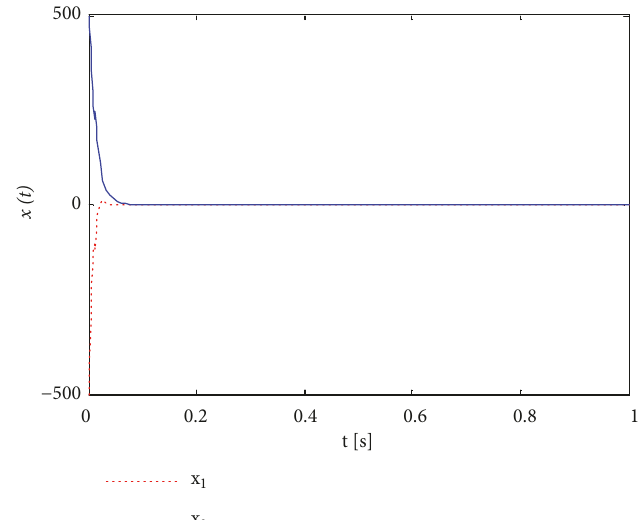
Figure 5: The state response curve of the closed-loop system under the control of the memory state feedback controller when the initial value is expanded.